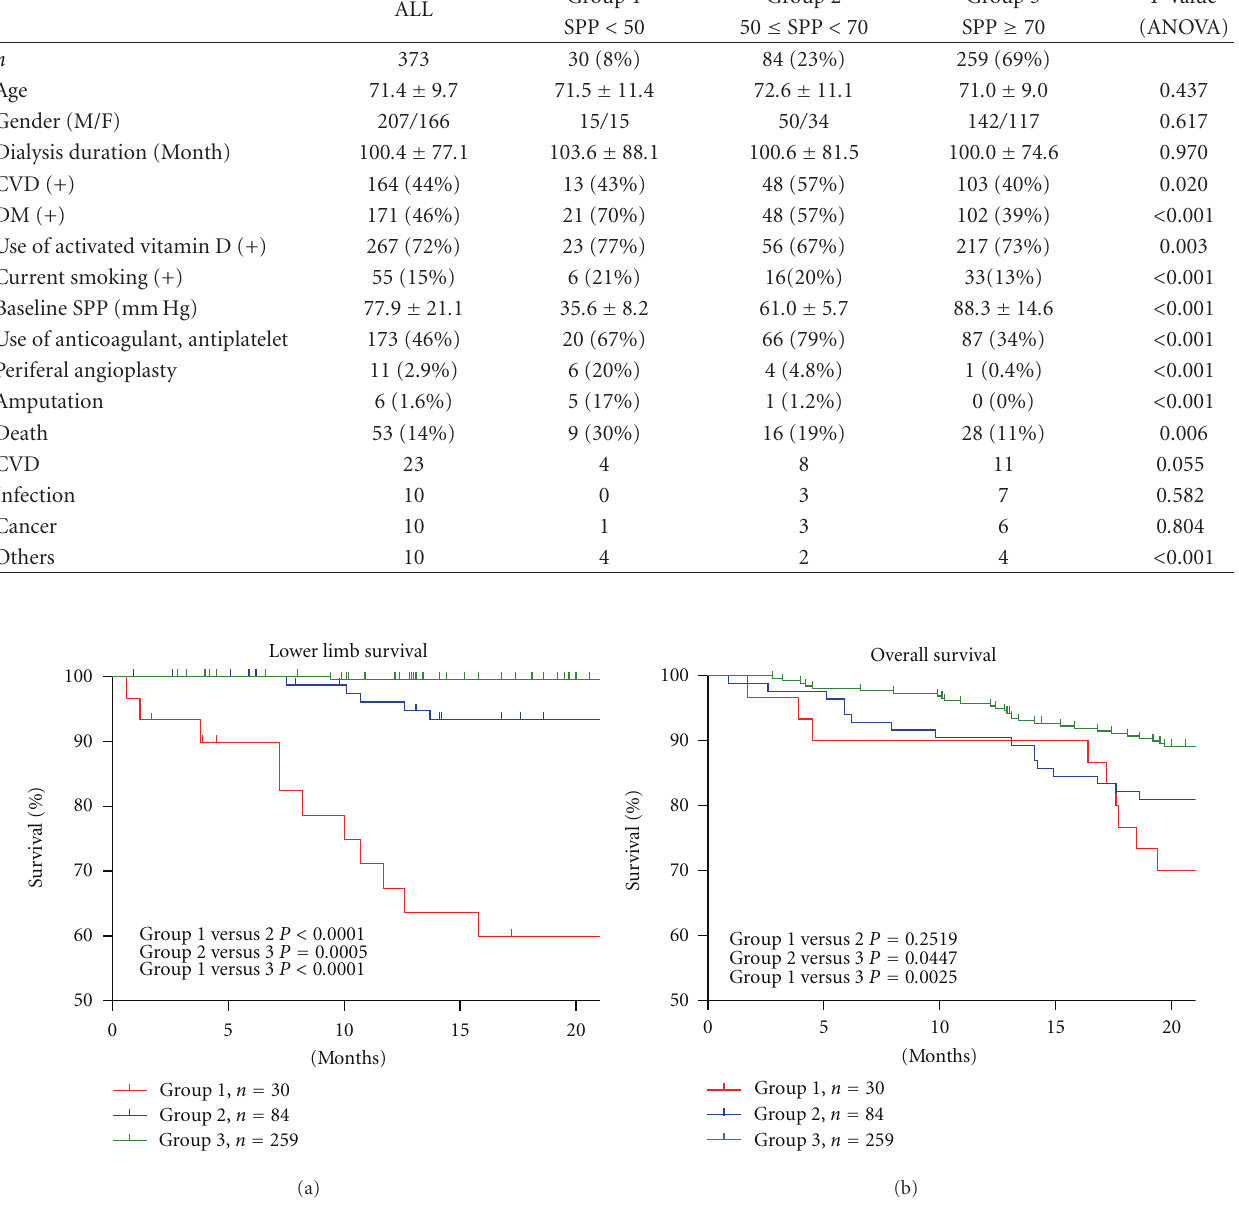
Figure 1: Lower limb survival and overall survival in the three groups. Patients were categorized according to the skin perfusion pressure (SPP) value: Group 1, < 50; Group 2, 50 ≤ SPP < 70; and Group 3, SPP ≥ 70. Group 1 showed poorer lower limb survival compared to other groups. Group 2 showed better survival compared to Group 1 ( P < 0 . 0001) but a poor prognosis for lower limb survival compared to Group 3 ( P = 0 . 0005). No significant di ff erence in overall survival was observed between Groups 1 and 2 ( P = 0 .